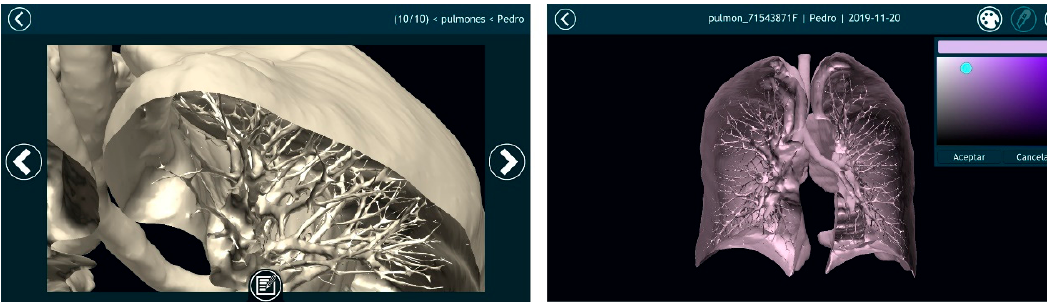
Figure 15. Left image shows a screenshot where the professional can add comments that can be